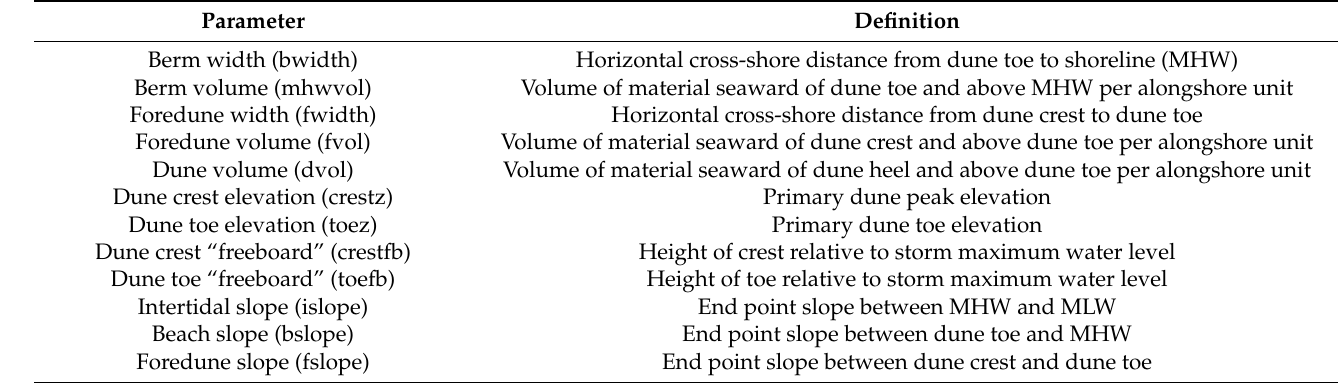
Figure 3. Example of extracted morphologic parameters for surveyed pre- and post-storm profiles. Table 2. List of extracted morphologic parameters.